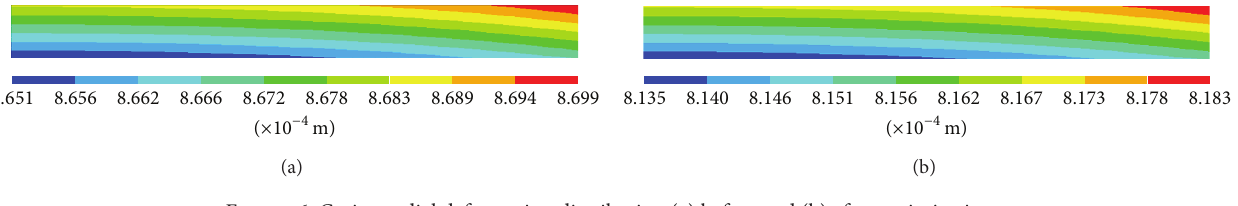
Figure 6: Casing radial deformation distribution (a) before and (b) after